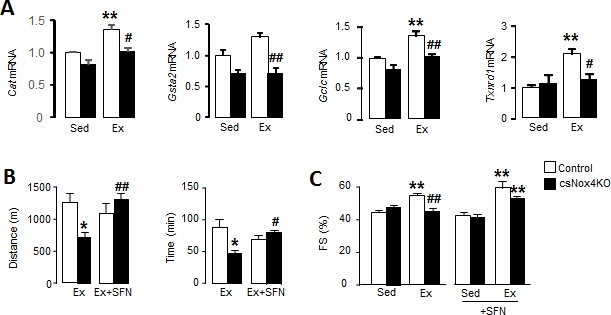
Cardiac Nox4 deficiency impairs heart function and exercise capacity due to lack of Nrf2 activation.(A) Expression of Nrf2-related genes in hearts of cardiomyocyte-specific Nox4KO (csNox4KO) and littermate controls after exercise (Ex). n = 3–4/group. **p<0.01 vs respective sedentary controls (Sed); #p<0.05, ##p<0.01 vs Control/Ex. (B) Maximal exercise distance and time. n = 3–5/group. *p<0.05 vs Control/Ex; #p<0.05, ##p<0.01 vs csNox4KO/Ex, 1-way ANOVA followed by Tukey post hoc analysis. (C) Fractional shortening (FS) evaluated by conscious echocardiography in control and csNox4KO mice immediately after the exercise capacity test. Some animals were treated with sulforaphane (SFN) prior to exercise. n = 4–12/group. **p<0.01 vs Sed; ##p<0.01 vs Control/Ex, 2-way ANOVA followed by Tukey post hoc analysis. Cat: catalase, Gsta2: glutathione S-transferase A2, Gclc: glutamate cysteine ligase catalytic subunit, Txnrd1: thioredoxin reductase 1.